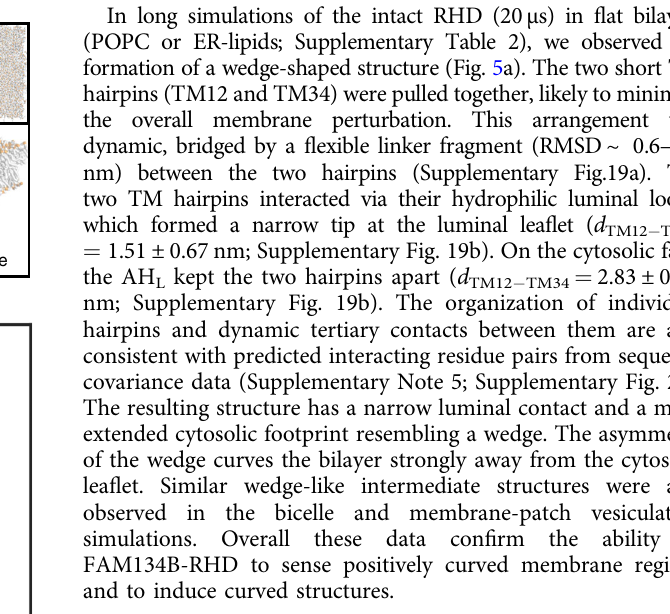
Fig. 4b, green histograms). In control simulations with the KALP 15 peptide, we observed a preference for surfaces with small mean curvature ( H ( x, y ) ≈ 0.0011 nm − 1 ); Fig. 4b, blue histo- grams). Detailed 2D histograms of preferred principal curvatures ( k 1 and k 2 ) revealed that FAM134B-RHD associates with regions of positive principal curvatures, resembling local bulges of the buckle (Gaussian curvature K G > 0 corresponding to ellipsoidal vesicle shapes; Supplementary Fig. 16). Control simulations with KALP 15 showed that the peptide associates with regions of both positive and negative principal curvatures, indicating preference for local gentle saddle-like regions of the buckle ( K G < 0; Supplementary Fig. 16; Supplementary movie 5).